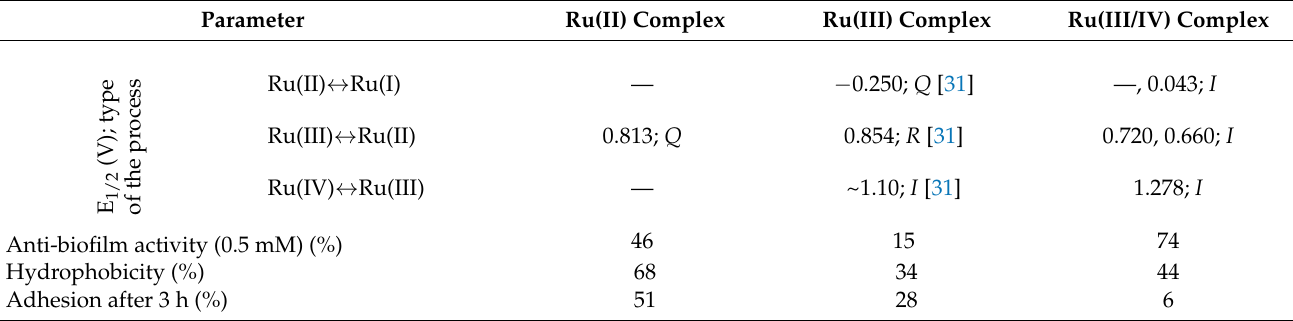
Table 3. Comparison of physicochemical properties (scan rate 100 mV) with biological effects for the Ru complexes. Parameter Ru(II) Complex Ru(III) Complex Ru(III/IV)